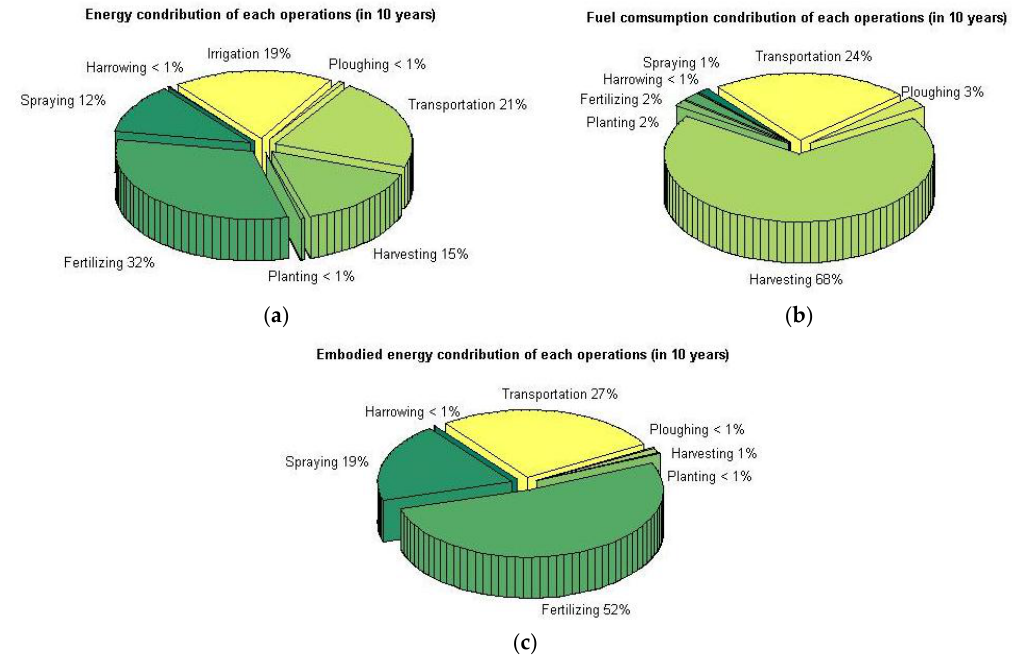
Figure 6. Distribution of the total energy input ( a ), fuel consumption ( b ), and embodied energy ( c ) to the various operations for the basic scenario.